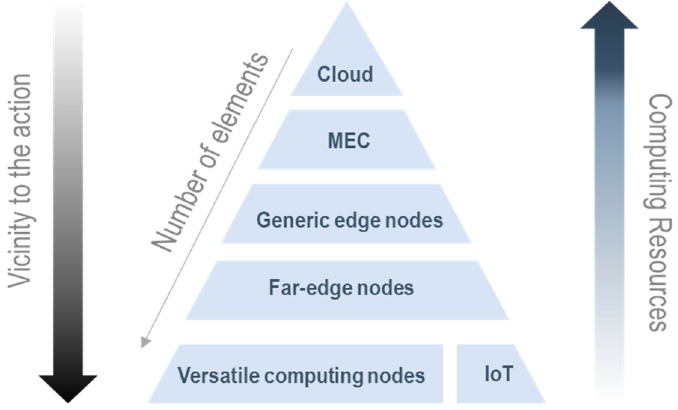
Figure 4. Classification of the heterogeneous nodes according to their spot on the continuum.